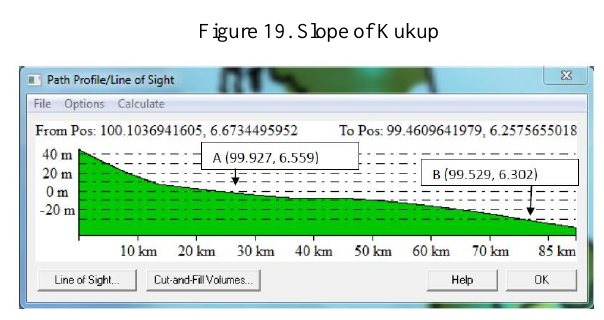
Figure 20. Slope of Langkawi